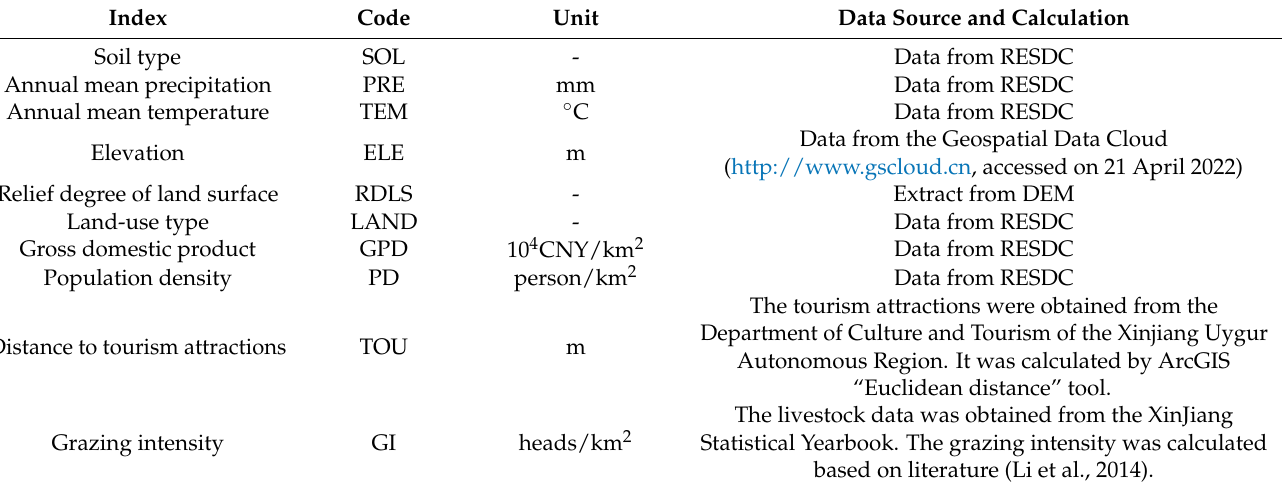
Table 3. Details of the driving factors.